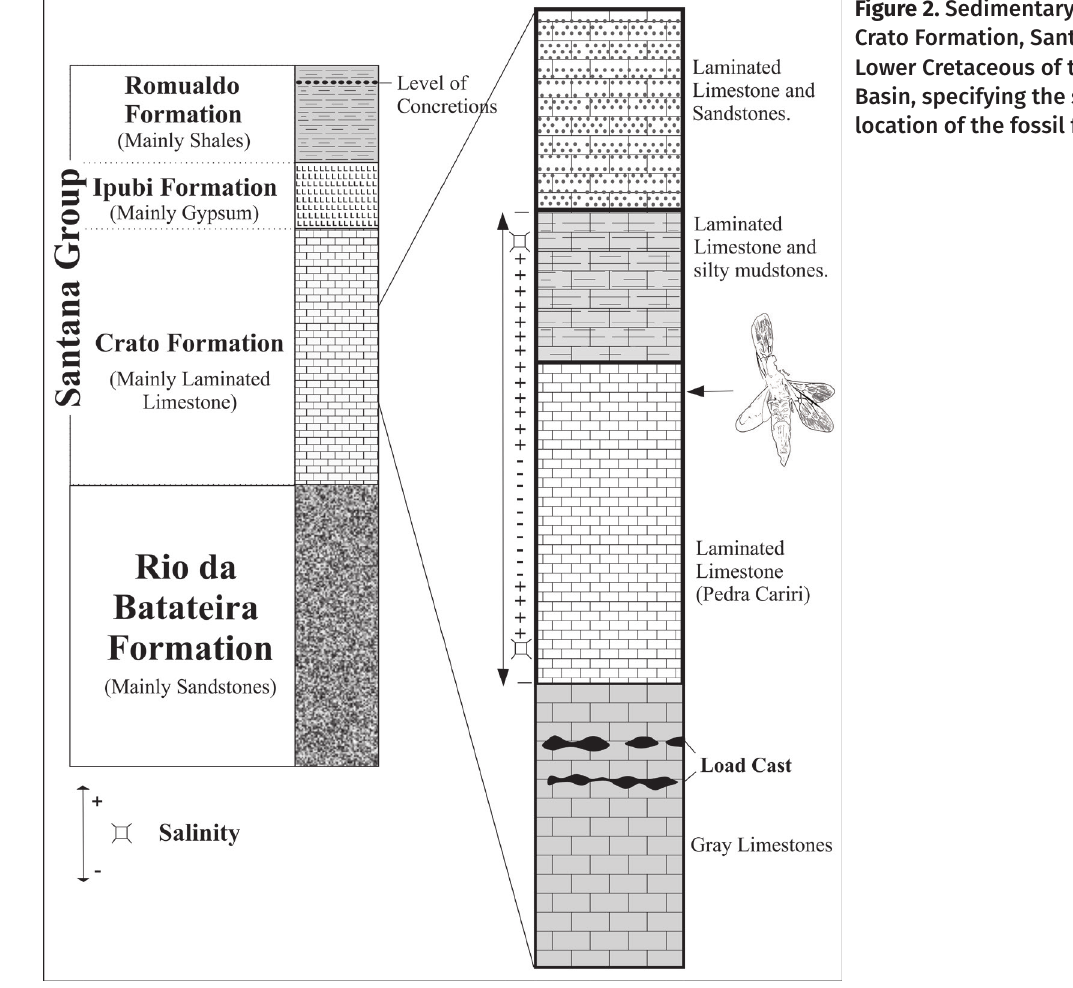
Figure 2. Sedimentary facies of the Crato Formation, Santana Group, Lower Cretaceous of the Araripe Basin, specifying the stratigraphic location of the fossil